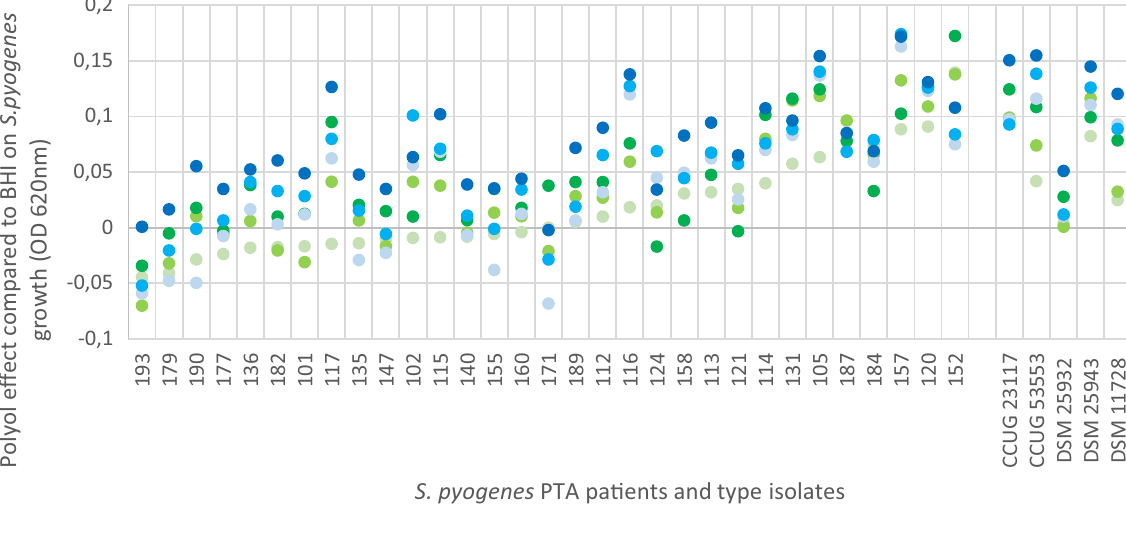
Figure 3. Effect of erythritol and xylitol on S. pyogenes PTA isolates and type strains compared to BHI. For each condition (e.g. for polyol ERY at 2.5%), the difference between the polyol growth data and BHI growth data (OD value of BHI minus OD value of polyol solution) is represented. The colored circles above the value “0” in Y axis are “inhibited growth”, values below the value “0” are enhanced growth, and on the value “0” is “no change”. The growth inhibition was detected in 28/31 of the isolates in the presence of at least one concentration of ERY and in 30/31 isolates of